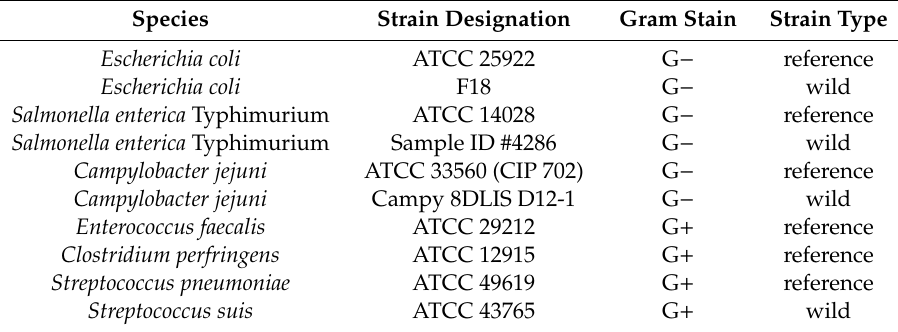
Table 6. Information of tested bacterial